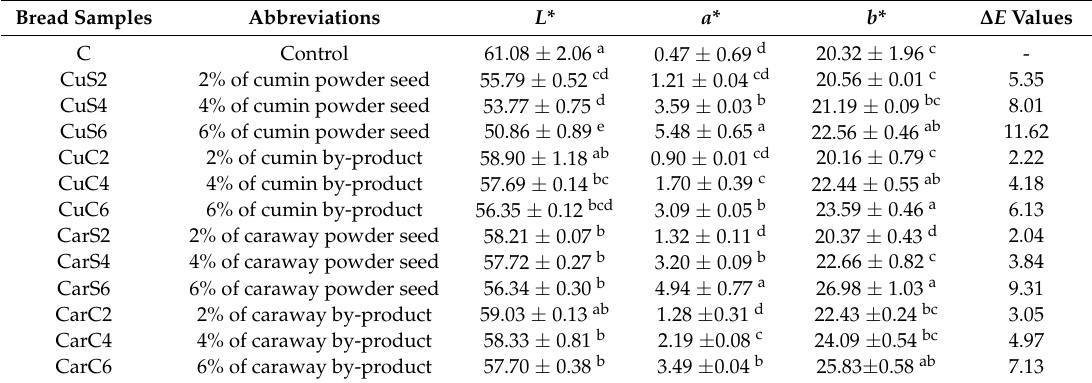
Table 1. Abbreviations of the samples used in the present article, crumb color analysis and total colour difference ( ∆ E ) values of protein bread fortified with cumin and caraway seeds and by-product. Bread